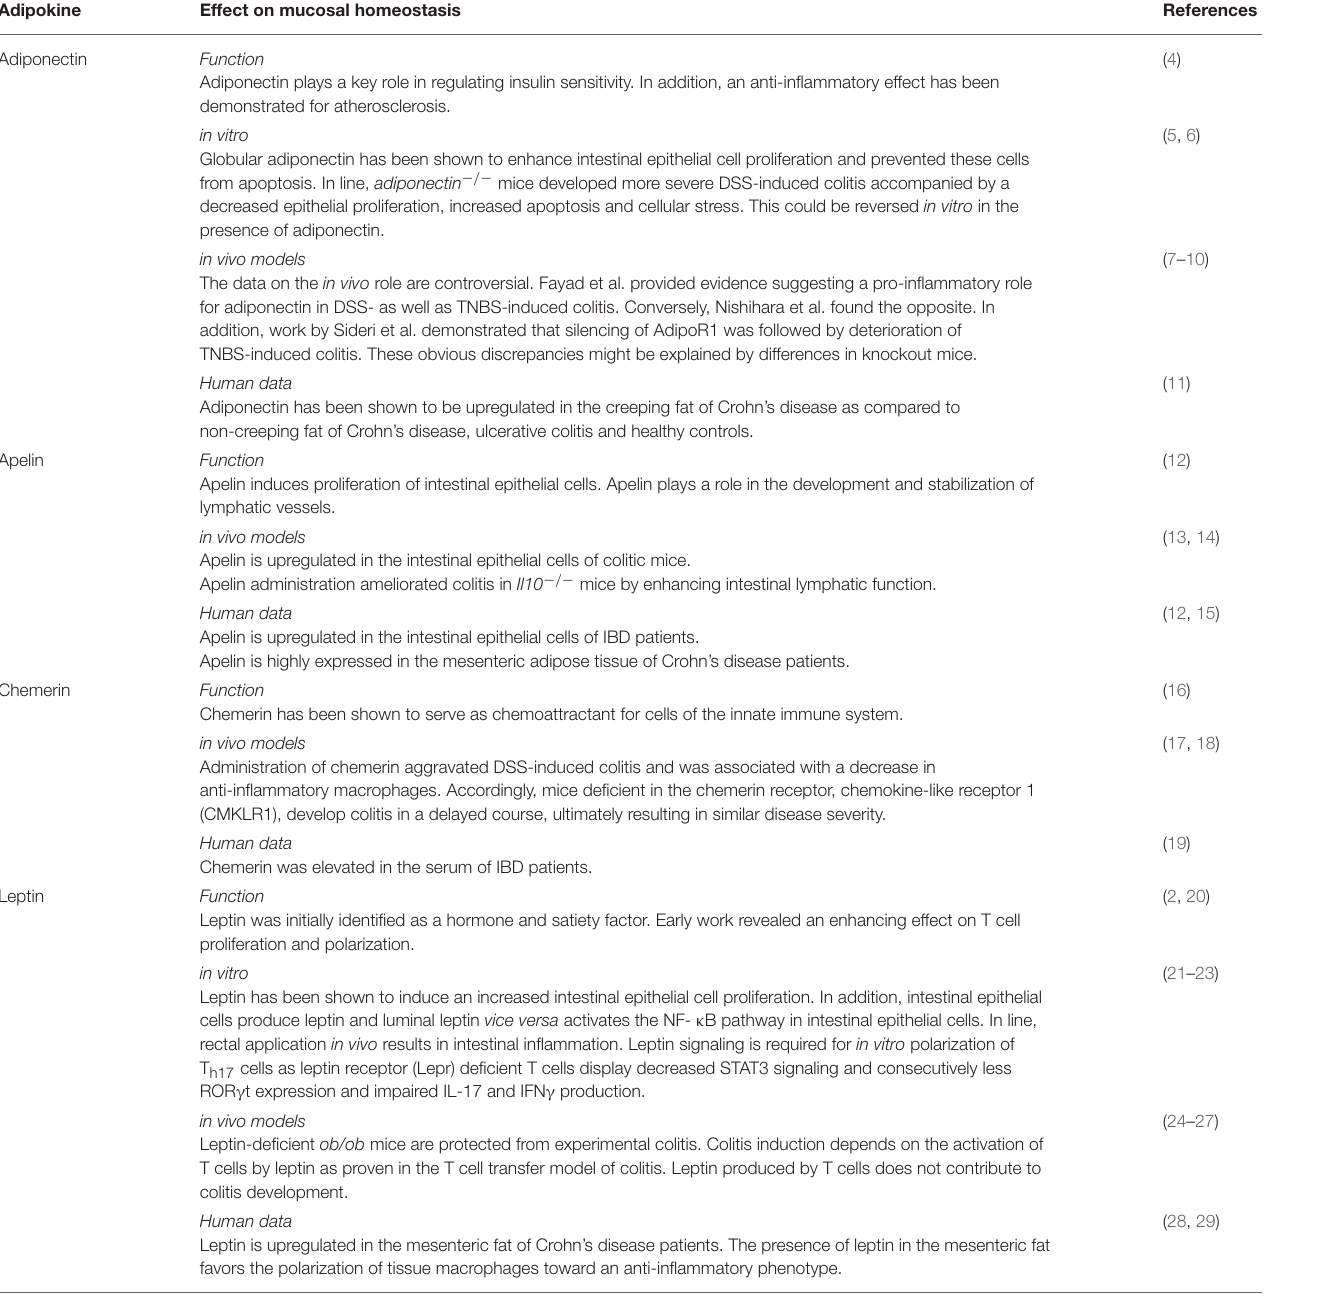
TABLE 1 | Adipokines and the regulatory effect on intestinal homeostasis.